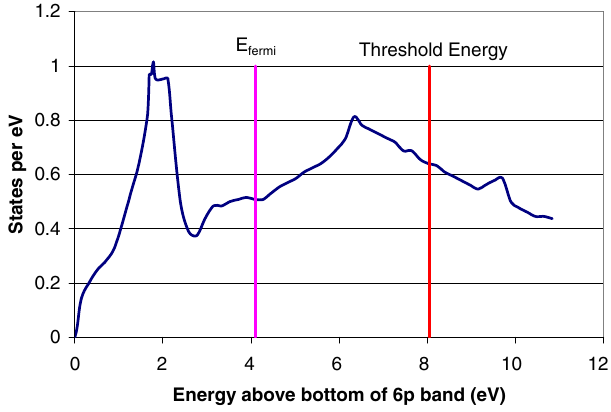
FIG. 1. (Color) Density of electron states of lead [18]. Note that zero energy is taken to be the bottom of the 6 p